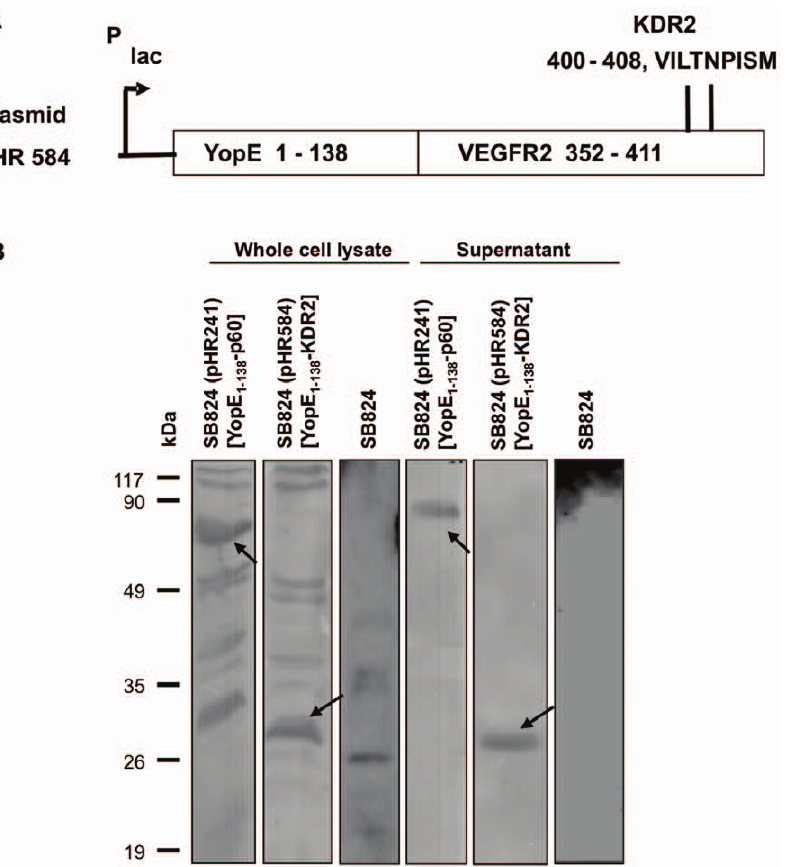
Figure 1. Construction of chimeric protein YopE 1–138 /VEGFR2 352–411 and its secretion efficacy. A Schematic representation of the translational fusion of YopE 1–138 and VEGFR2 352–411 encoded by plasmid pHR584. B Western blot analysis of hybrid protein YopE 1–138 /VEGFR2 352–411 showing its stable production and efficient secretion into the Salmonella culture supernatant. SB824 (pHR241) expressing YopE 1–138 -p60 served as a positive and plasmid-less SB824 as a negative control.